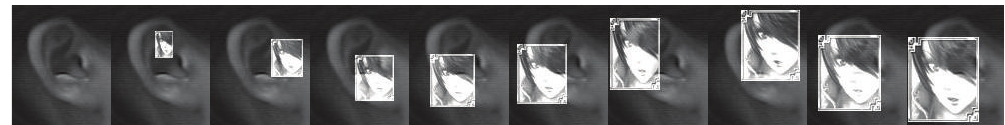
Figure 6: Occluded test ear images from USTB ear database III.